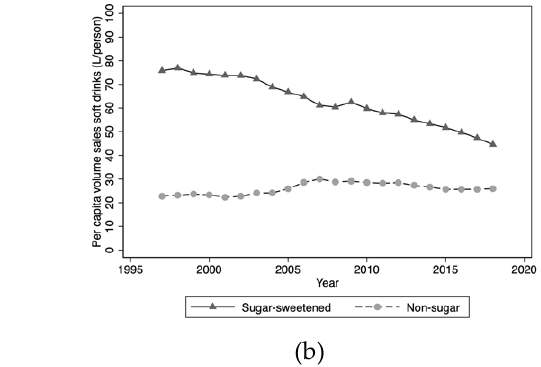
Figure 1. ( a ) Per capita volume sales: Sugar-sweetened water-based beverages and non-sugar water-based beverages; ( b ) Per capita volume sales: Sugar-sweetened carbonated soft drinks and non-sugar carbonated soft drinks.